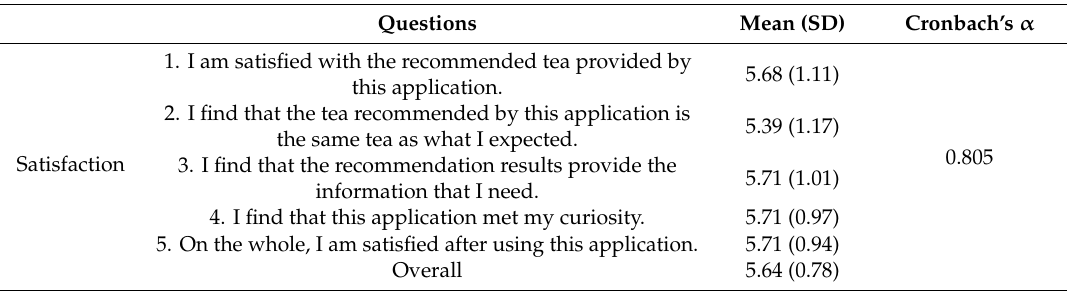
Table 4. Satisfaction with TeaPick TM .